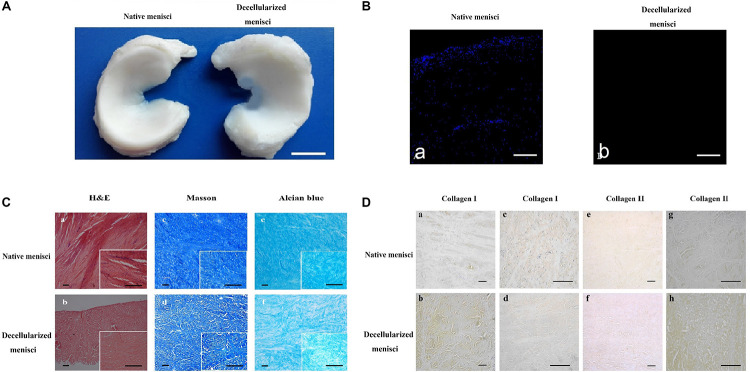
Histological and immunohistochemical analysis of native meniscus and decellularized meniscus. (A) Gross morphological inspections of native meniscus and meniscus scaffold. Overall shape of the scaffold was maintained after processing. Scale bar: 10 mm. (B) DAPI staining of longitudinal section of native and acellular meniscus scaffold (a,b). Scale bar: 100 μm. (C) H&E staining of (a) native and (b) decellularized meniscus. Masson’s trichrome staining: (c) native and (d) decellularized meniscus; collagen is blue, cytoplasm is pink and nuclei are brown. Alcian blue staining of GAG: (e) native and (f) decellularized meniscus. Scale bar: 100 μm. (D) Collagen I labeling of tissue cross-sections: (a) native and (b) decellularized. Collagen I labeling of longitudinal section: (c) native and (d) decellularized. Collagen II labeling of tissue cross-sections: (e) native and (f) decellularized. Collagen II labeling of longitudinal section: (g) native and (h) decellularized. Scale bar: 100 μm.